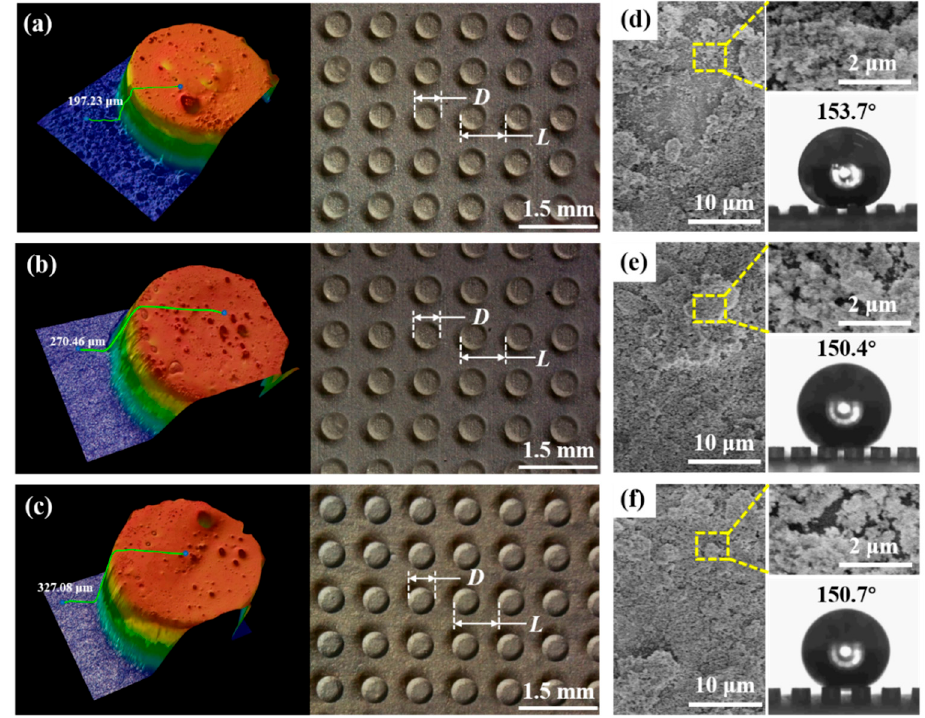
Figure 2. Morphologies of the superhydrophobic micro-nanostructure surfaces. ( a – c ) Three-dimensional topographies of array microstructures. ( d – f ) Higher magnification SEM images of the nanostructures on the surfaces of the array microstructures.